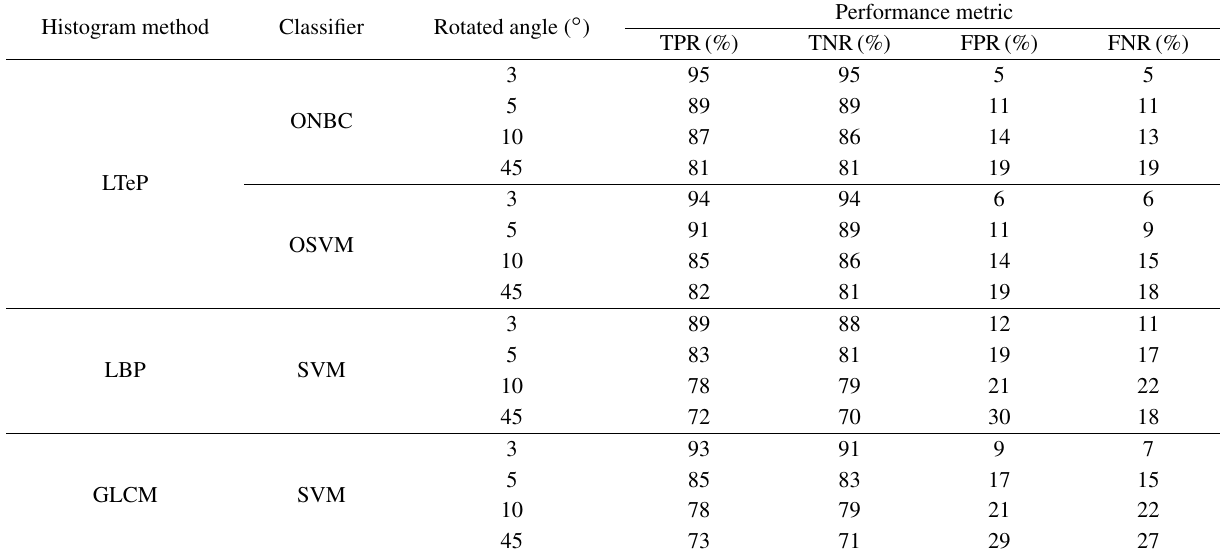
Table 2 Performance of the proposed CMFD algorithms on post-processing attack of angle rotation.